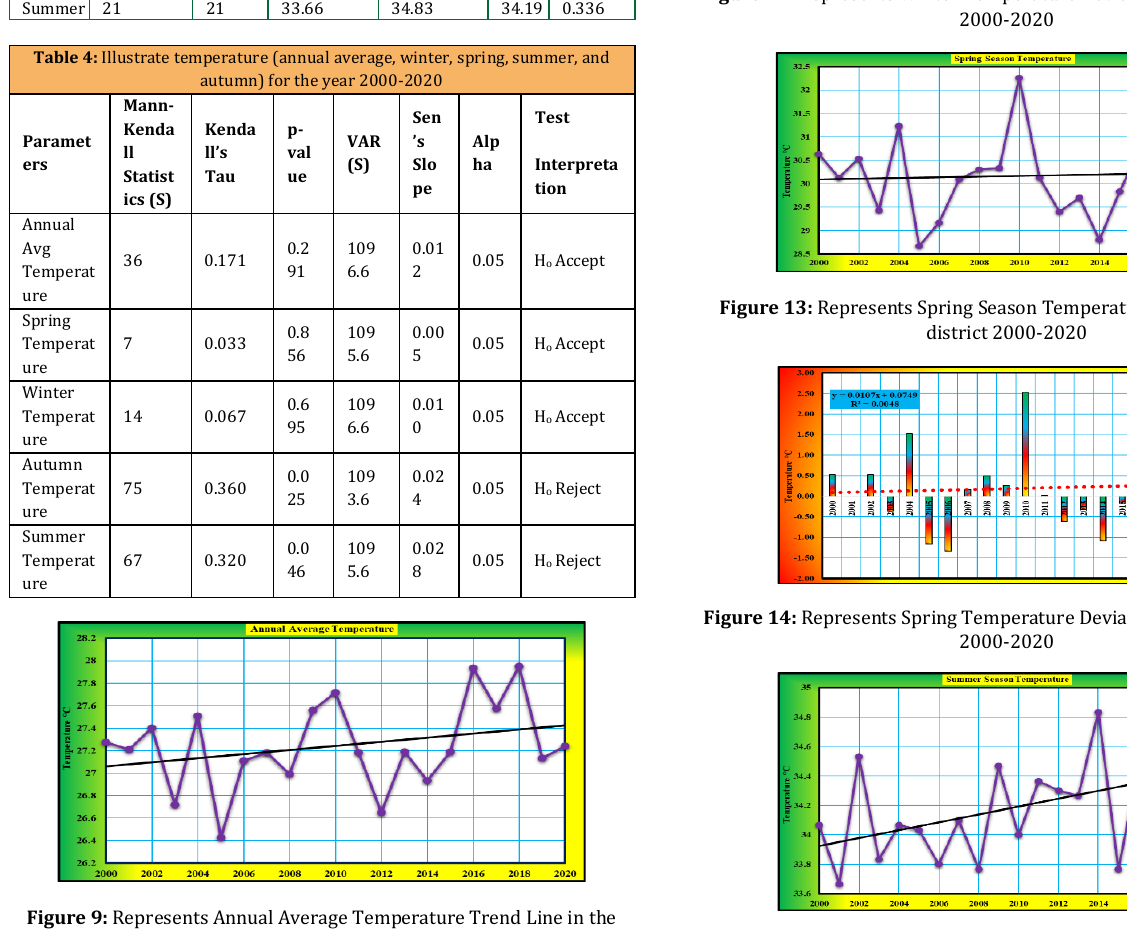
Figure 15: Represents Summer Season Temperature Trend in Ghotki district